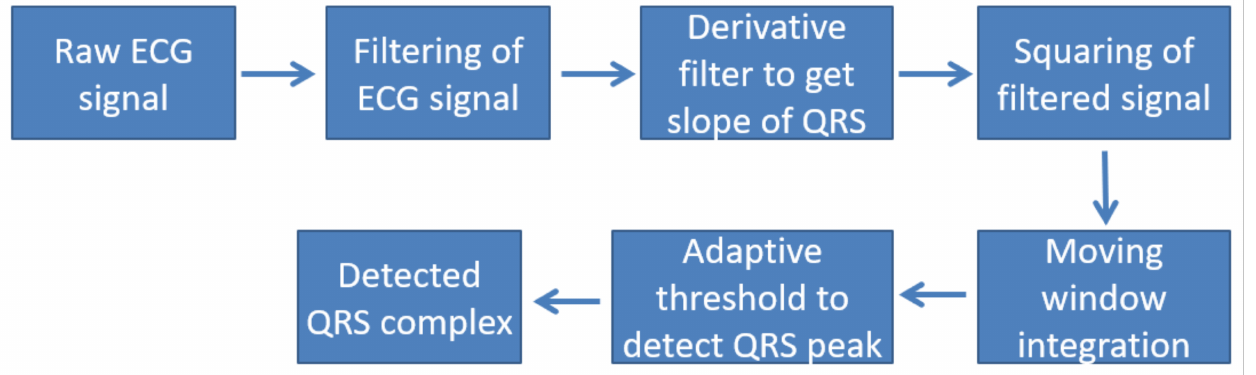
Figure 4. Block diagram of Pan–Tompkin’s algorithm